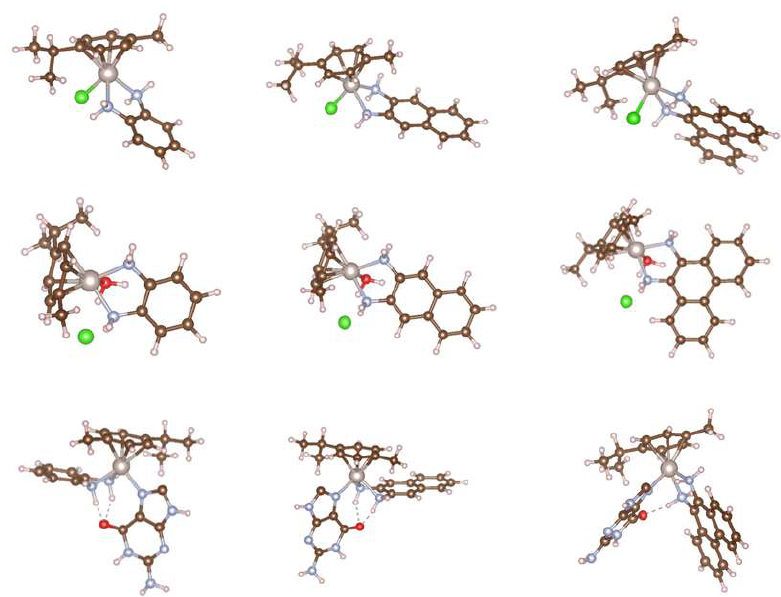
Figure 4. Optimized structures of complexes 1 ( left ), 2 ( middle ) and 3 ( right ) along with their aqua and guanine adducts, showing the changes in the plane angle of the aromatic system.